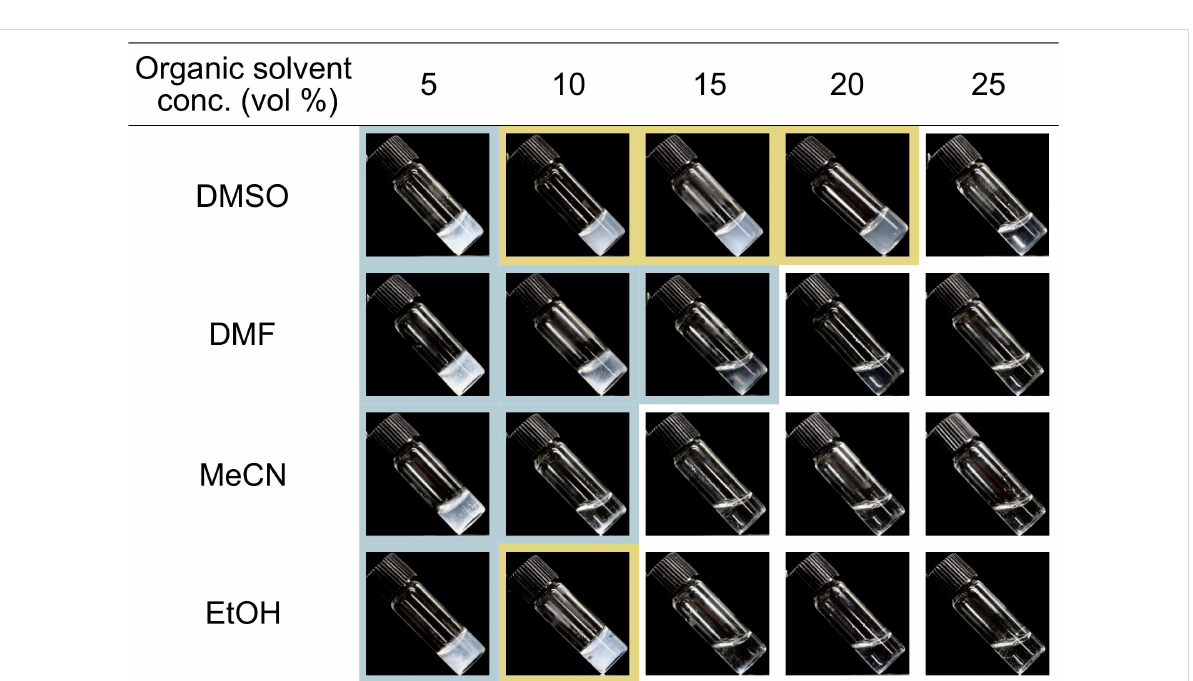
Figure 2: Photographs of the reaction mixtures with organic solvents after the CDP-catalyzed oligomerization reaction. The blue, yellow, and white backgrounds denote the precipitate state, gel state, and trace amount of the products, respectively.